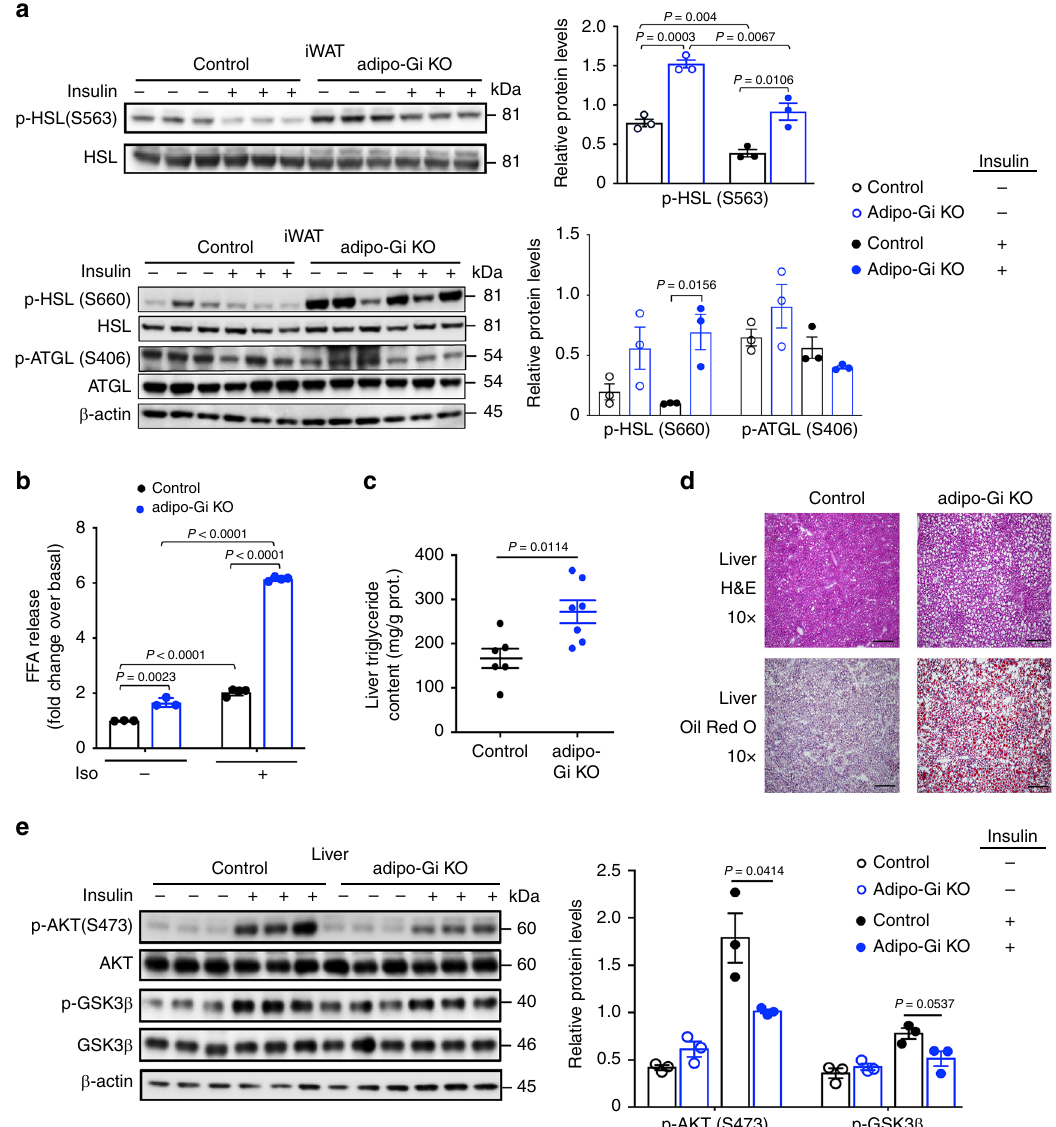
Fig. 2 Lack of G i signaling in adipocytes increases lipolysis and causes liver steatosis. a Western blotting analysis of p-HSL/HSL protein expression levels in iWAT prepared from HFD control and adipo-Gi KO mice. Mice (males) were injected with 5 U of insulin (i.v.), and iWAT was collected 5 min later ( n = 3 per group). b In vitro lipolysis assay. Primary adipocytes prepared from iWAT of control and adipo-Gi KO mice were left either untreated ( n = 3 per group) or incubated with 1 μ M isoproterenol (Iso; n = 4 per group). c , Liver triglyceride content of HFD control and adipo-Gi KO mice (control, n = 6; adipo- Gi KO, n = 7). d Representative images of H&E- and Oil Red O-stained liver tissues of HFD control and adipo-Gi KO mice ( n = 4 per group; scale bars = 200 μ m). e Western blotting analysis of hepatic insulin signaling. HFD control and adipo-Gi KO mice were injected i.v. with either saline or insulin (5 U). Liver tissue was collected 5 min later and processed for immunoblotting studies ( n = 3 per group). Data are given as means ± s.e.m. P values are indicated in the different panels. ( a , b , e : two-way ANOVA followed by Bonferroni ’ s post hoc test; c : two-tailed Student ’ s t test). Source data are provided as a Source data fi